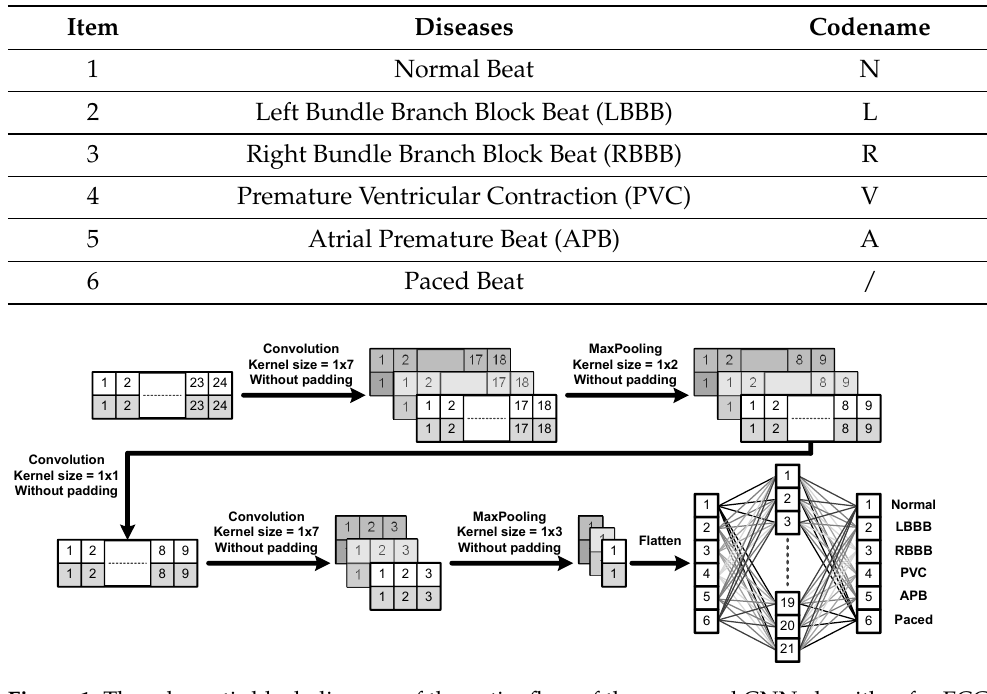
Figure 1. The schematic block diagram of the entire flow of the proposed CNN algorithm for ECG heart beat classification.